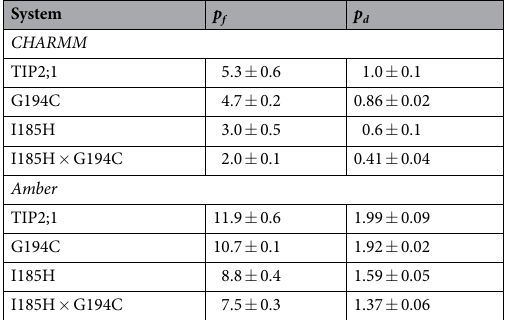
Table 2. Water permeabilities. p f and p d are given in units of 10 − 14 cm 3 s − 1